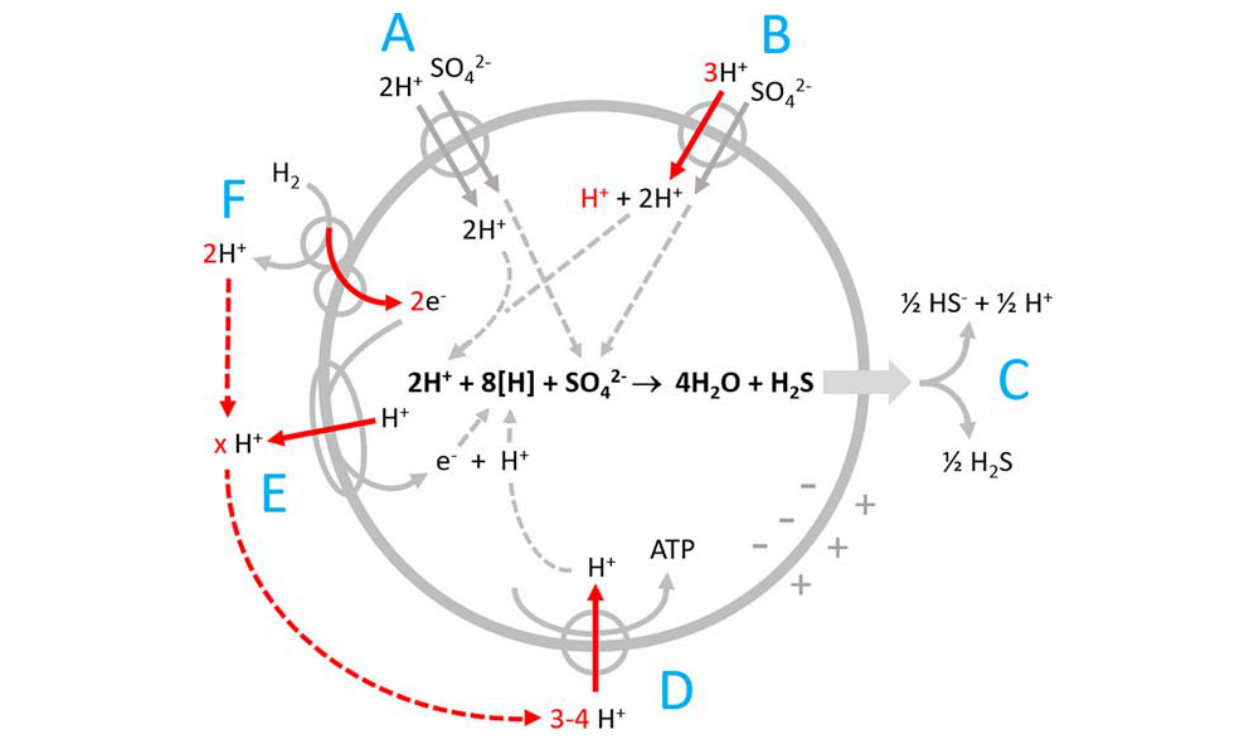
FIGURE 1 | Proton-related processes in Desulfovibrio during sulfate reduction with hydrogen. (A) Electroneutral proton-sulfate symport; (B) electrogenic proton-sulfate symport; (C) release of H 2 S by diffusion and partial dissociation to H + + HS − ; (D) ATP synthase; (E) proton-translocating electron transport chain; and (F) periplasmic hydrogenase coupled to cytochrome c that channels electrons into the cell by vectorial electron transport. Red arrows point to electrogenic vectorial processes.